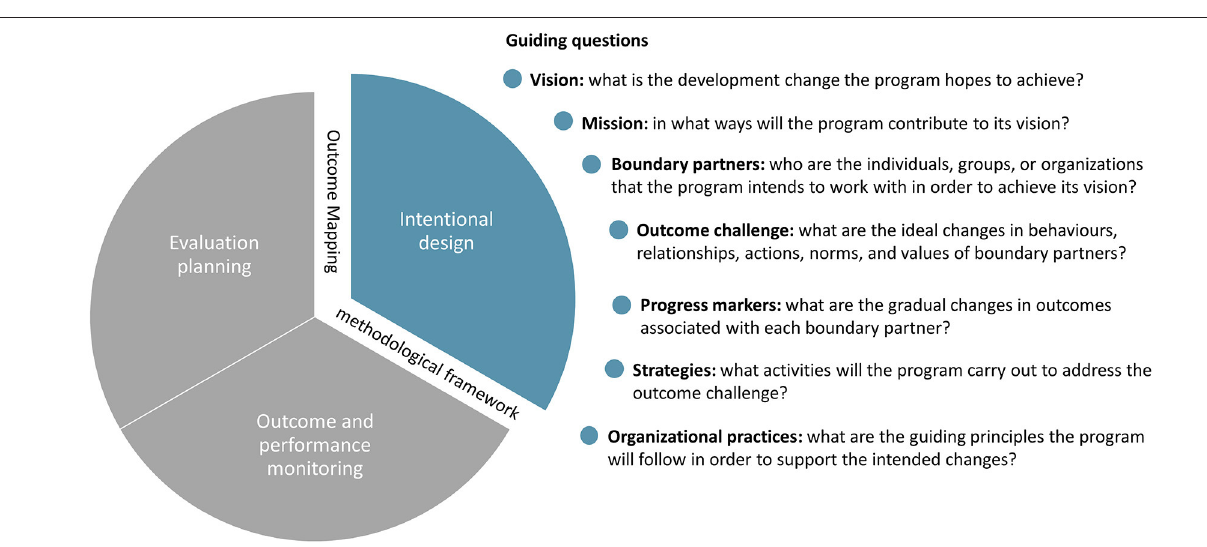
FIGURE 2 | Outcome mapping methodological framework and guiding